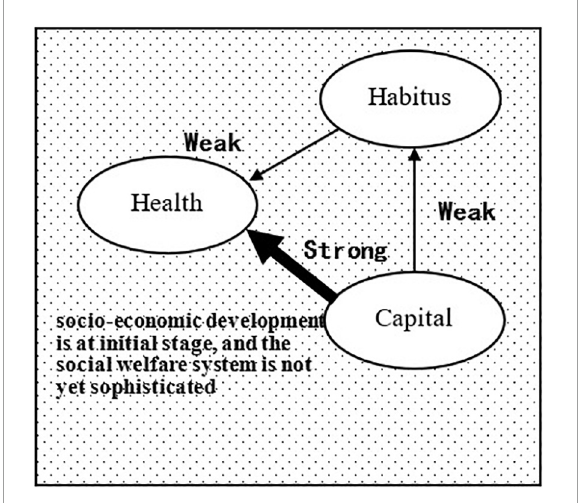
FIGURE3 Health field of the elderly in developing countries.